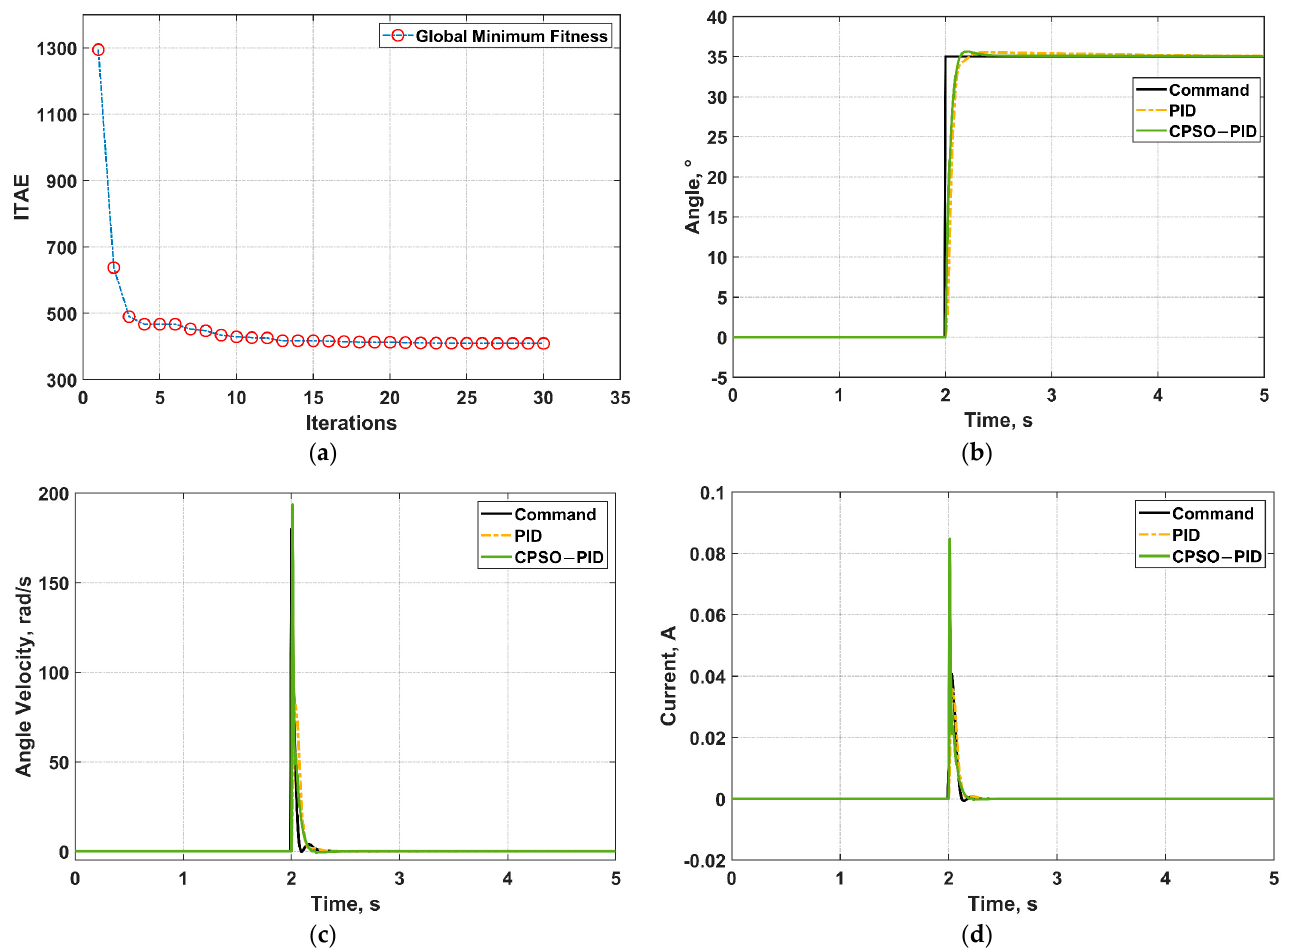
Figure 11. Comparison results of CPSO − PID and PID in the case of angle step signal. ( a ) Global minimum fitness convergence process; ( b ) Angle control; ( c ) Angle velocity control; ( d ) Current control. Table 2. Comparison of CPSO-PID and PID performance indexes.